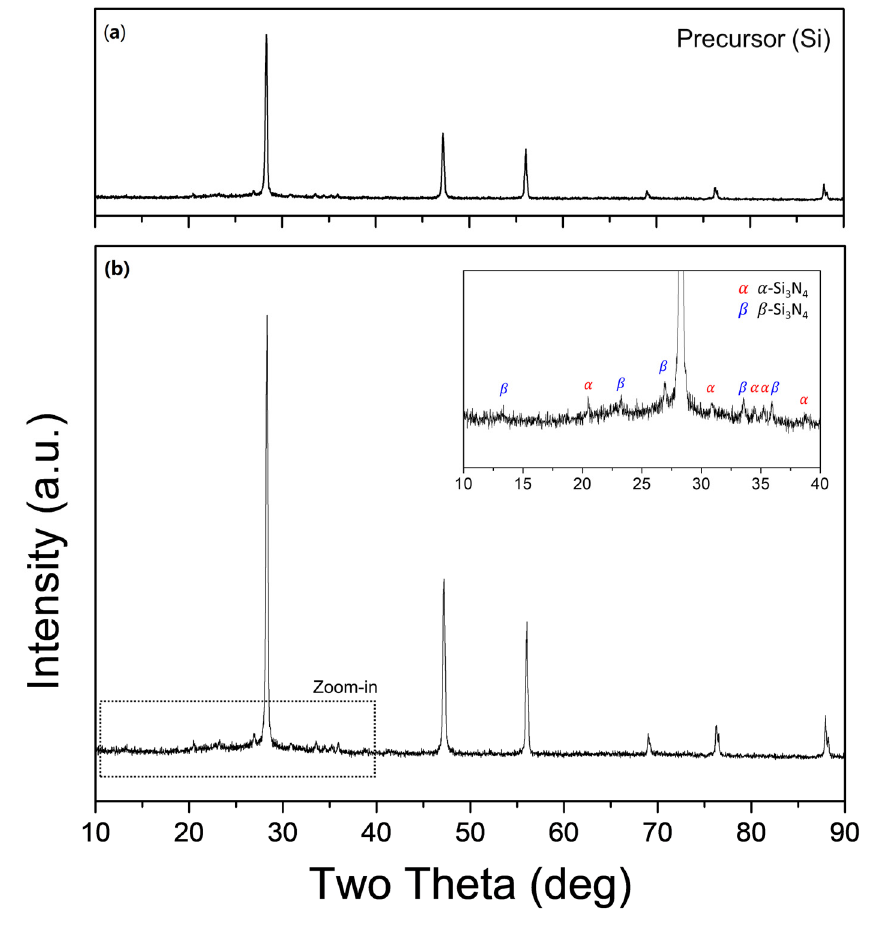
Figure 2. X-ray diffraction (XRD) patterns of ( a ) micro-Si powder as a precursor and ( b ) nanopowder synthesized in Run 1 (cylinder-type reaction tube). Inset shows an enlarged view of the graph (2 θ = 10–40 ◦